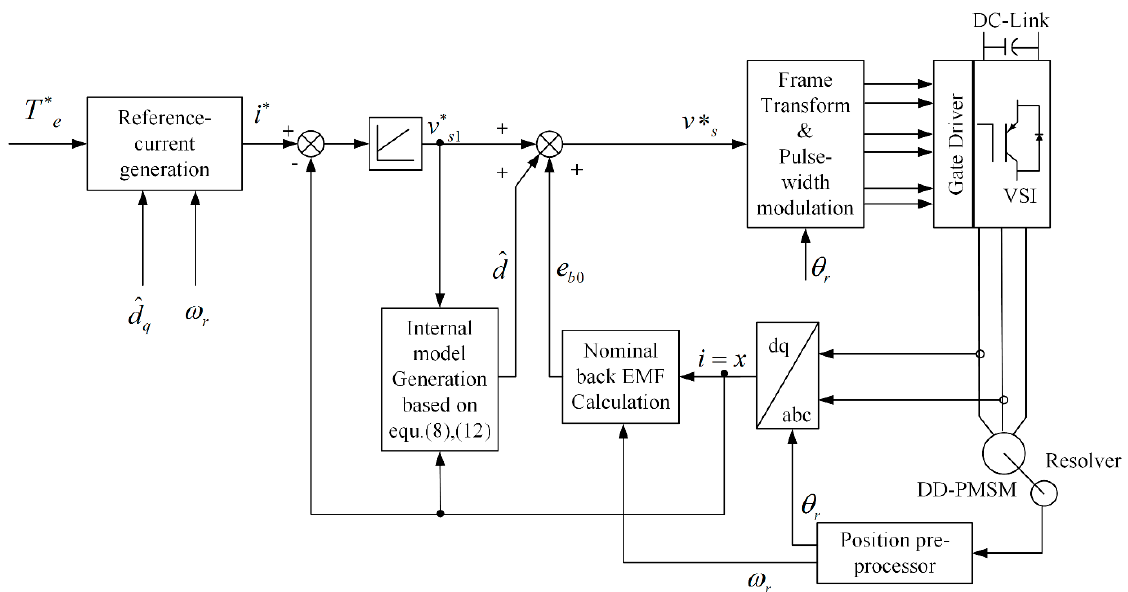
Figure 7. Overall block diagram for control scheme of Mohamed. Reprinted with permission from ref. [62]. Copyright 2008 IEEE.